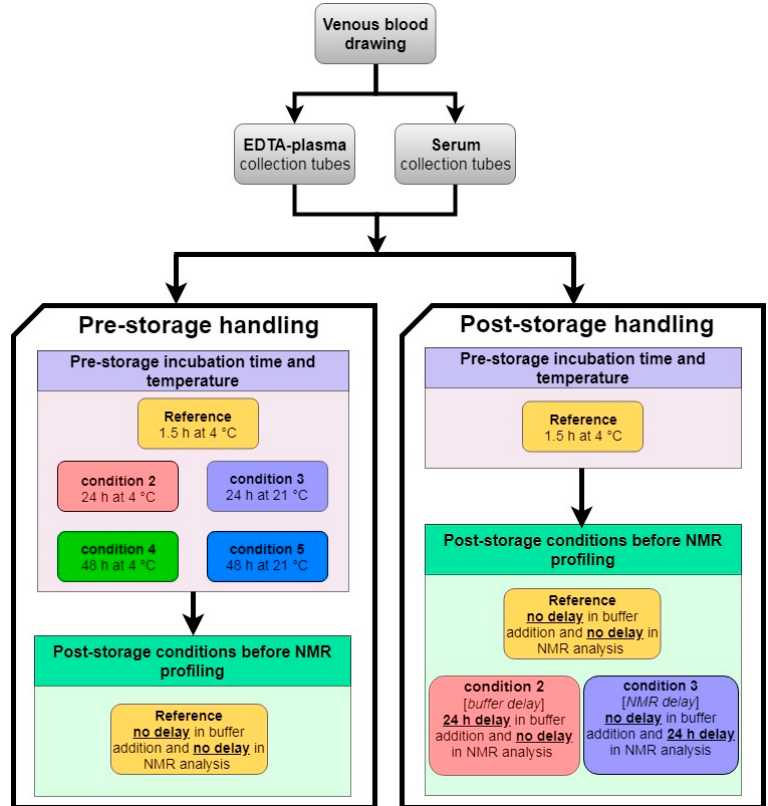
Figure 9. Experimental design diagram: pre- and post-storage handling conditions (Sections 4.2 and 4.3, respectively). NMR, nuclear magnetic resonance; buffer, sodium phosphate (see Supplementary Methods for more information).